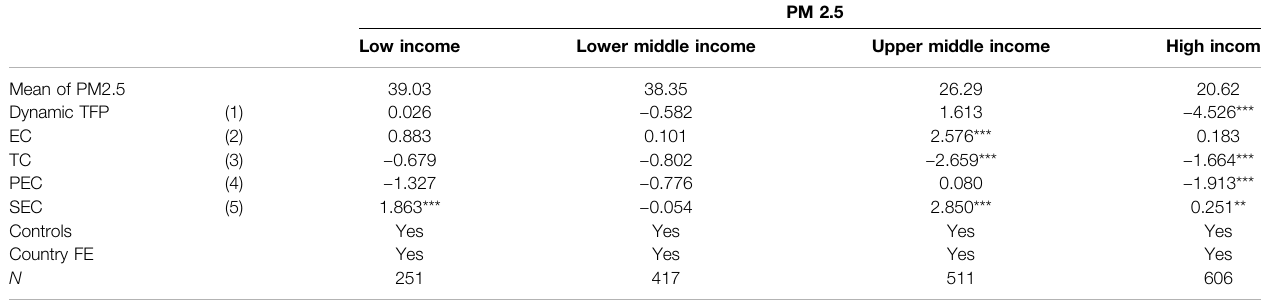
TABLE 8 | The estimation results for development level heterogeneity.